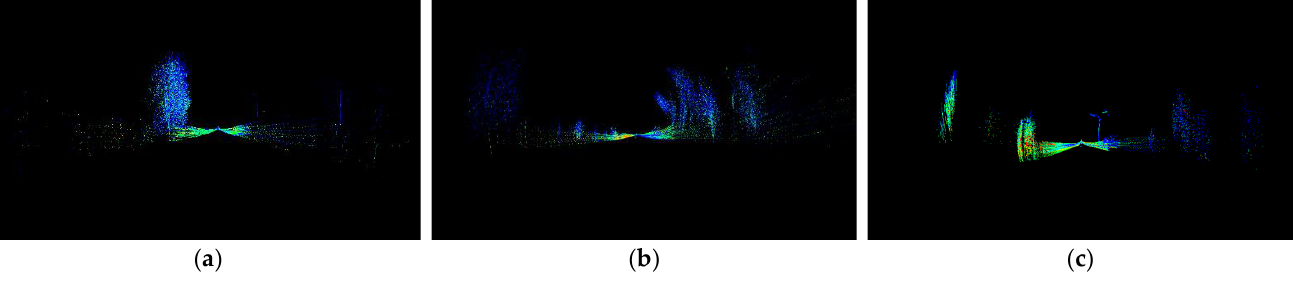
Figure 13. Point cloud image scene 9: Field-House-counter-S16 ( a ) Picture 1, ( b ) Picture 2, ( c ) Picture 3.